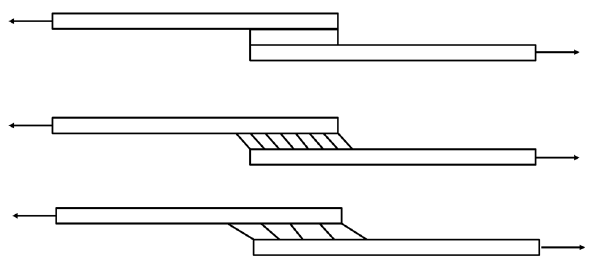
Figure 1. Schematic lap shear specimen at low loads and no adhesive elongation ( top ), intermediate loads with even adhesive elongation and shear stress ( center ), and at high loads with uneven adhesive elongation and shear stress ( bottom ).